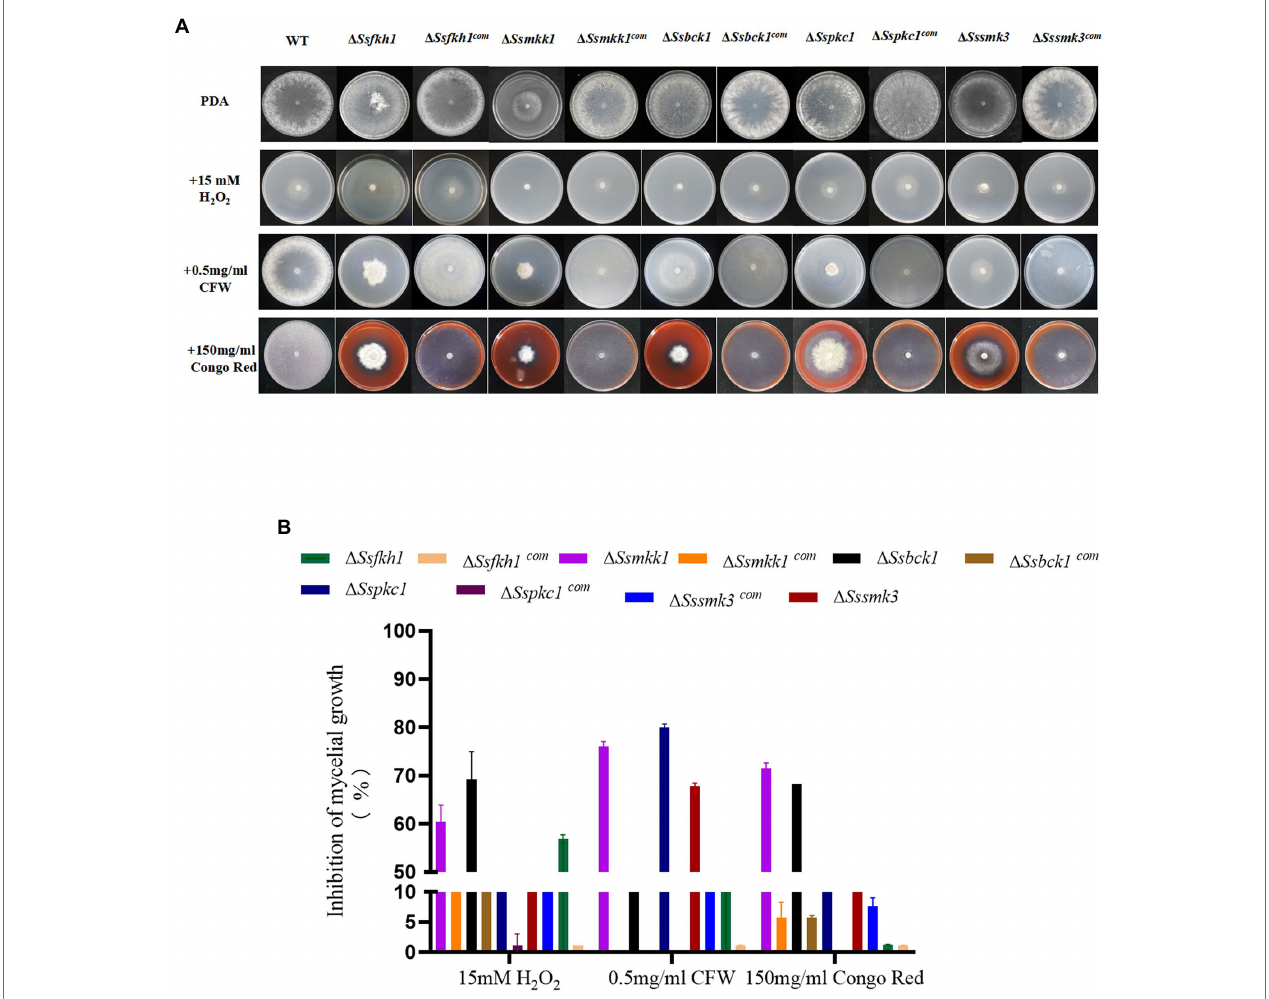
FIGURE 2 | (A) Sensitivity of WT, Δ Ssfkh1 , Δ Ssmkk1 , Δ Sspkc1 , Δ Ssbck1 , Δ Sssmk3 , Δ Ssfkh1 com , Δ Ssmkk1 com , Δ Sspkc1 com , Δ Ssbck1 com , and Δ Sssmk3 com strains to 15 mM H 2 O 2 , 0.5 mg/ml Calcium fluoride white (CFW), 150 mg/ml Congo Red (CR) after incubation at 25 ° C for 3 days. Photographs were taken by 3 DAI. (B) Inhibition of mycelial growth of Δ Ssfkh1 , Δ Ssmkk1 , Δ Sspkc1 , Δ Ssbck1 , Δ Sssmk3 , Δ Ssfkh1 com , Δ Ssmkk1 com , Δ Sspkc1 com , Δ Ssbck1 com , and Δ Sssmk3 com strains. The experiment was repeated three